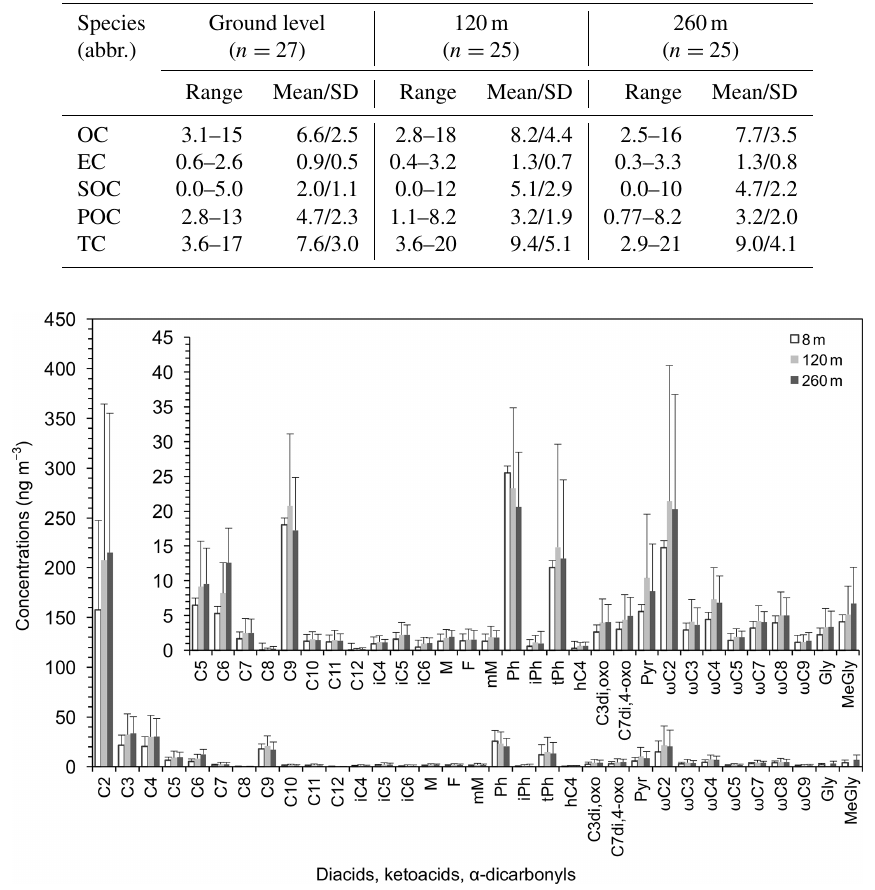
Figure 4. Molecular distributions of dicarboxylic acids and related compounds in the PM 2 . 5 samples collected at the tower from 15 August to 10 September 2015 in